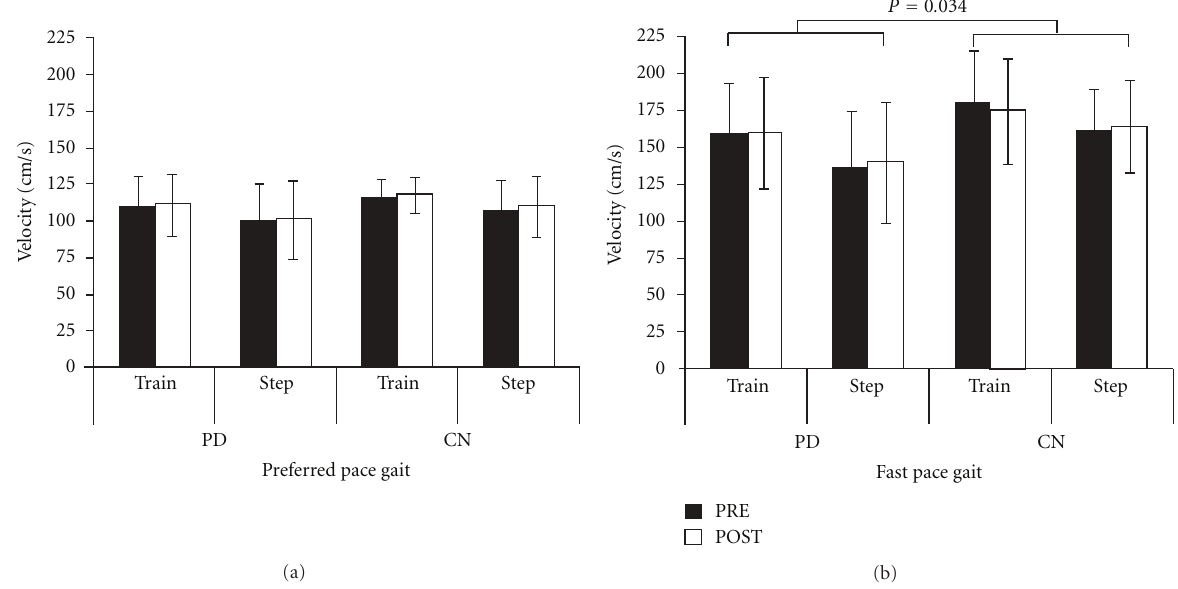
Figure 1: Gait Velocity. Mean preferred pace gait velocity (a) and fast as possible gait velocity (b) for PD and controls in the rotating treadmill training group (Train) and the stepping-in-place group (Step). Brackets indicate a significant group e ff ect. Error bars are SDs.